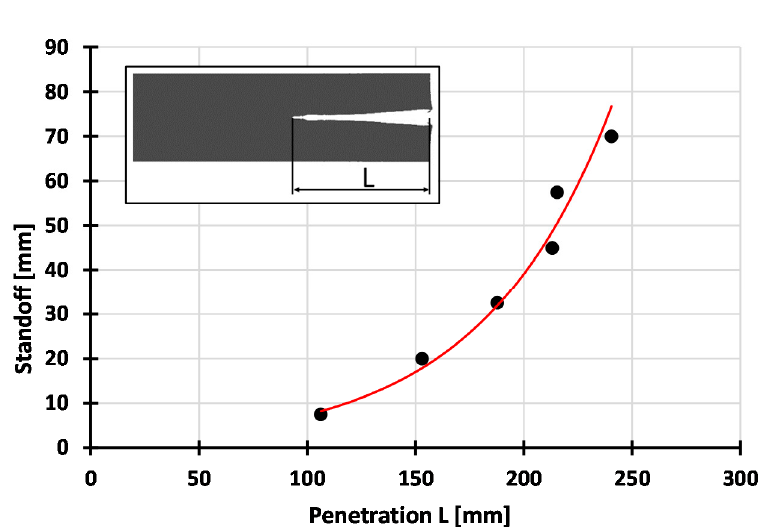
Figure 5. Characteristics of the change of penetration depth of the shaped charge in the steel block depending on the distance from the target.